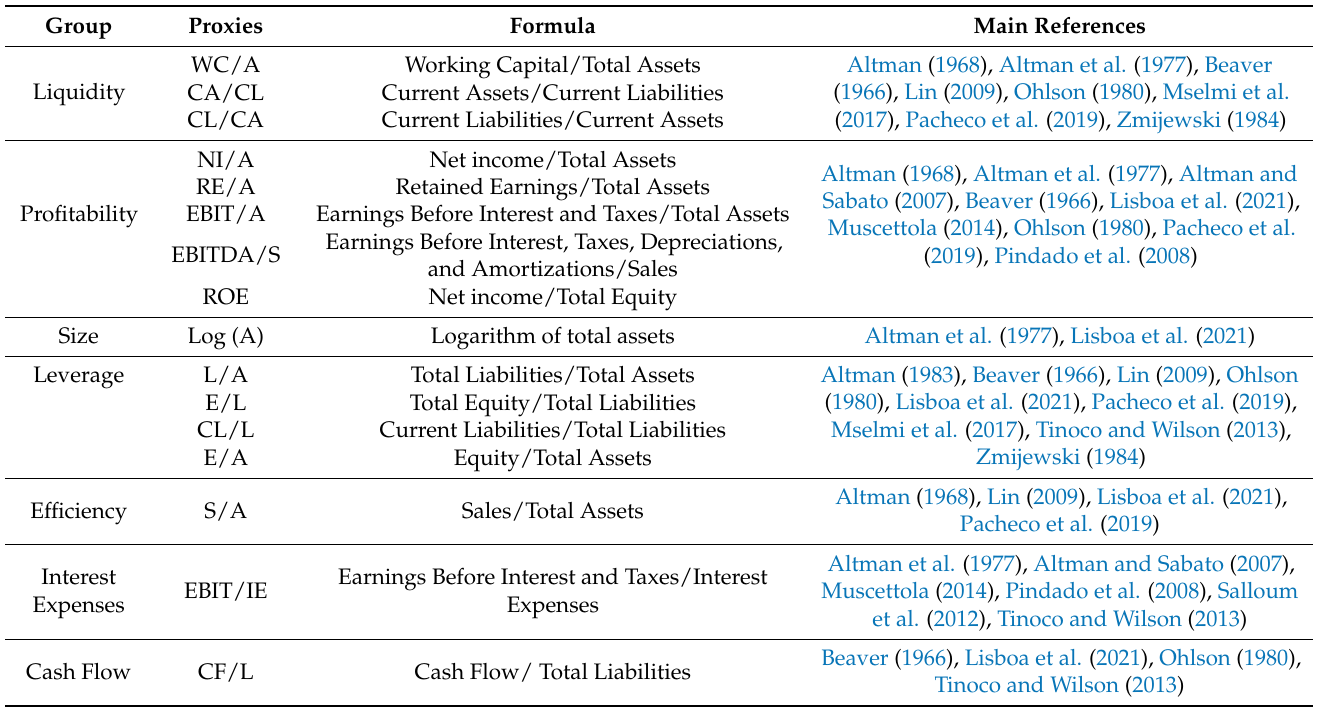
Table A1. Variable